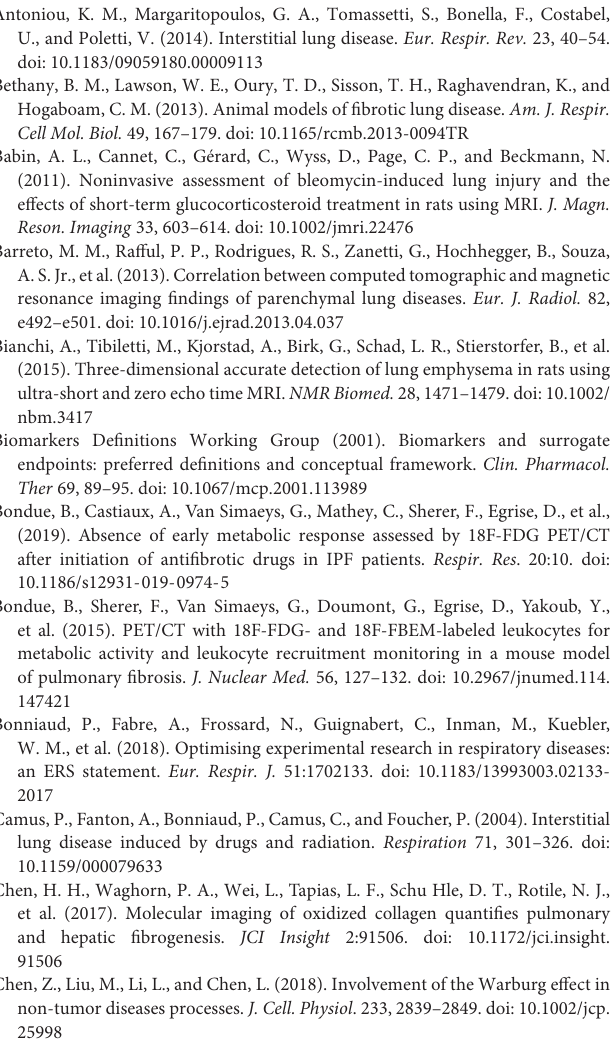
ratio for the whole group Significance was indicated by * when p < 0.05; p < 0.01 by ** and p < 0.001 by *** when comparing bleomycin towards the saline control from the same time point. The comparison of various time points between bleomycin-challenged groups is expressed as # when p < 0.05 and ## when p < 0.01. FIGURE S6 | Representative images of MRI echo times and multimodality images overlapping. (A) two different scans using TE LONG and TE SHORT are presented in a bleomycin-challenged rat and one saline control rat. (B) Overlap images from both PET and MR, demonstrating how the different layers of images and ROI could be aligned. This method enables data extraction within the same ROI generated. At the same time images acquired by different techniques can be complementary when assessing lesions. DATA FILE S1 | Extended section of the Materials and Methods. Study severity and adverse effects were described according to the ARRIVE guidelines, as well as the power calculations and n-numbers. DATA FILE S2 | Supporting material of the total lung volume from a pilot study. The total lung volume increase was observed in another experiment and set of animals, indicating the robustness of this imaging